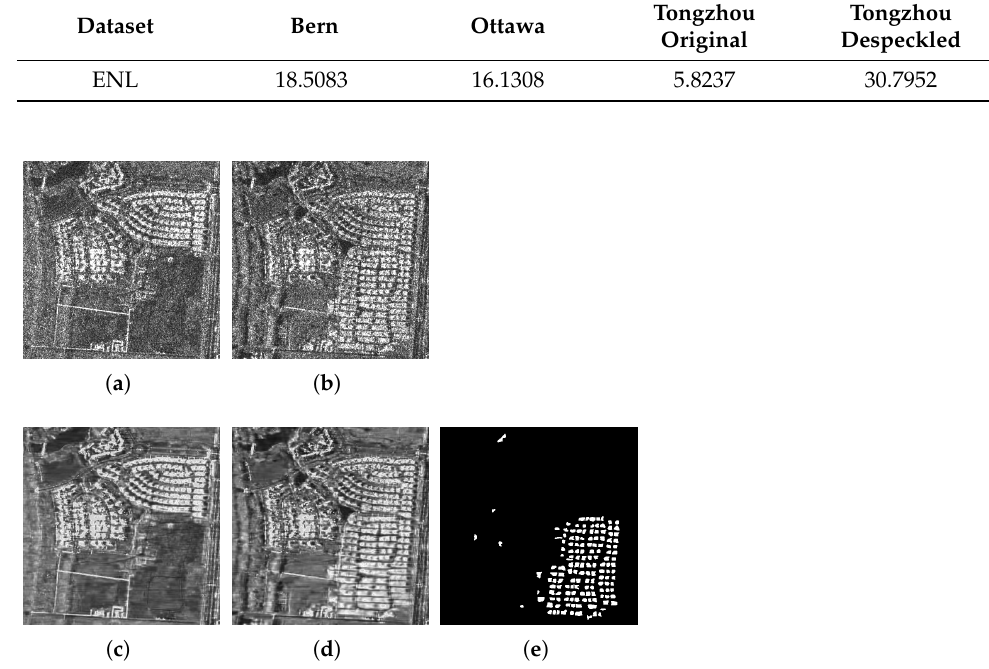
Figure 10. Tongzhou datasets before and after despeckling. The despeckled images are used in the experiments. ( a ) X 1 without despeckling; ( b ) X 2 without despeckling; ( c ) X 1 after despeckling; ( d ) X 2 after despeckling. ( e ) ground truth.